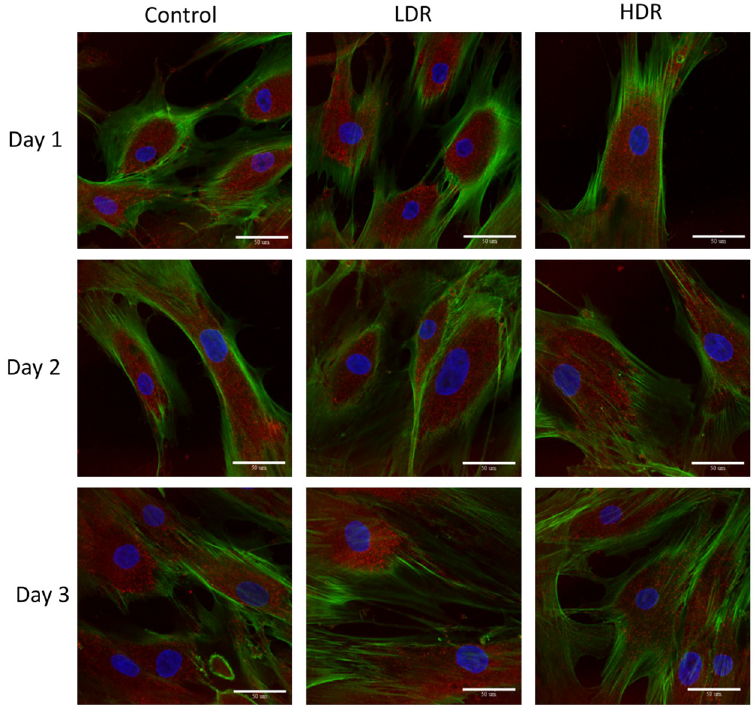
Fig 6. Representative images of p53 expression (red) in irradiated hADSCs, counterstained with phalloidin (green) and DAPI (blue). Images taken at 40x magnification. Bar = 50 μ m.